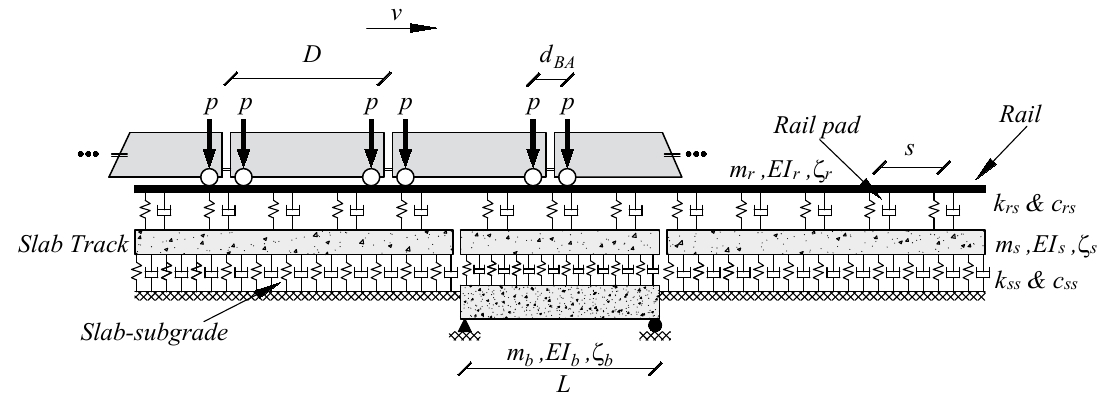
Figure 3. 2D computational model of the ballastless railway bridge.